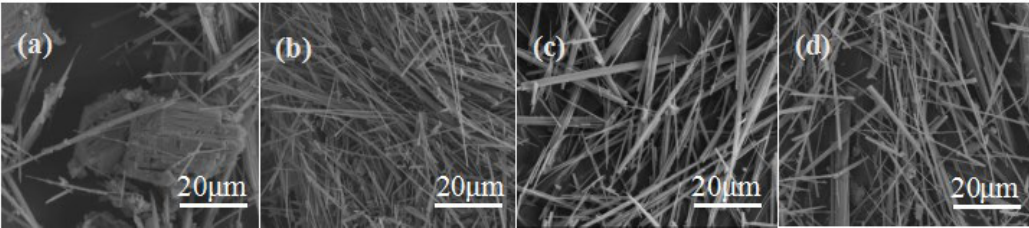
Figure 8. ESEM photos of CSHW at different reaction times: ( a ) 0.5 h, ( b ) 1 h, ( c ) 1.5 h, ( d ) 2 h.